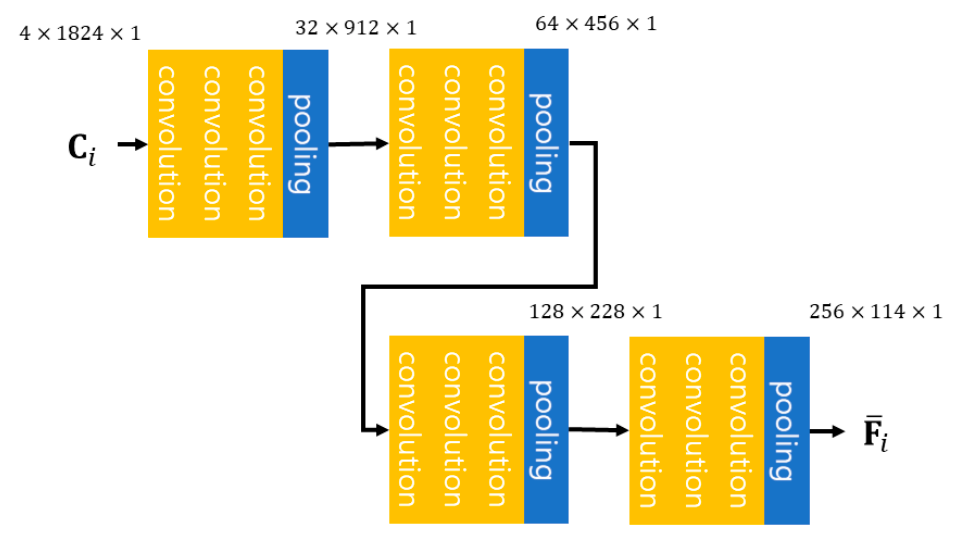
Figure 5. Configuration of a channel internal convolution network.